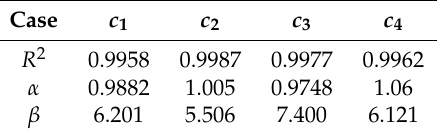
Table 3. Fitting parameters for data from Figure 10. Symbols: c 1 = 0 (indicating pure HA solution), c 2 = 5, c 3 = 10 and c 4 = 20 × 10 − 8